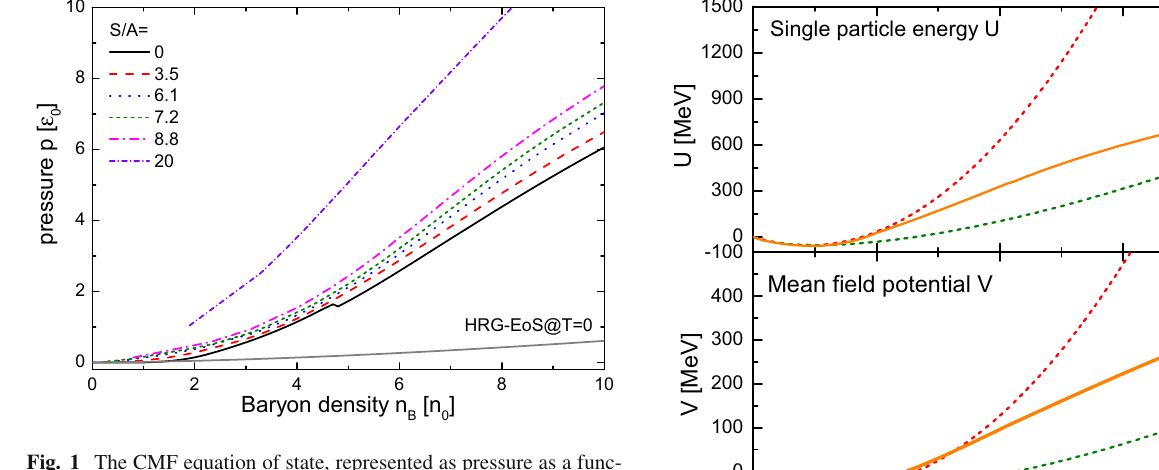
Fig. 1 The CMF equation of state, represented as pressure as a func- tion of the baryon density, for different values of constant entropy per baryon (S/A). The black solid line corresponds to the CMF-EoS at zero temperature, where around 4 n 0 a small kink in the pressure due to the phase transition can be observed. The same relation for the HRG-EoS at vanishing temperature is also shown as a grey line. The pressure in